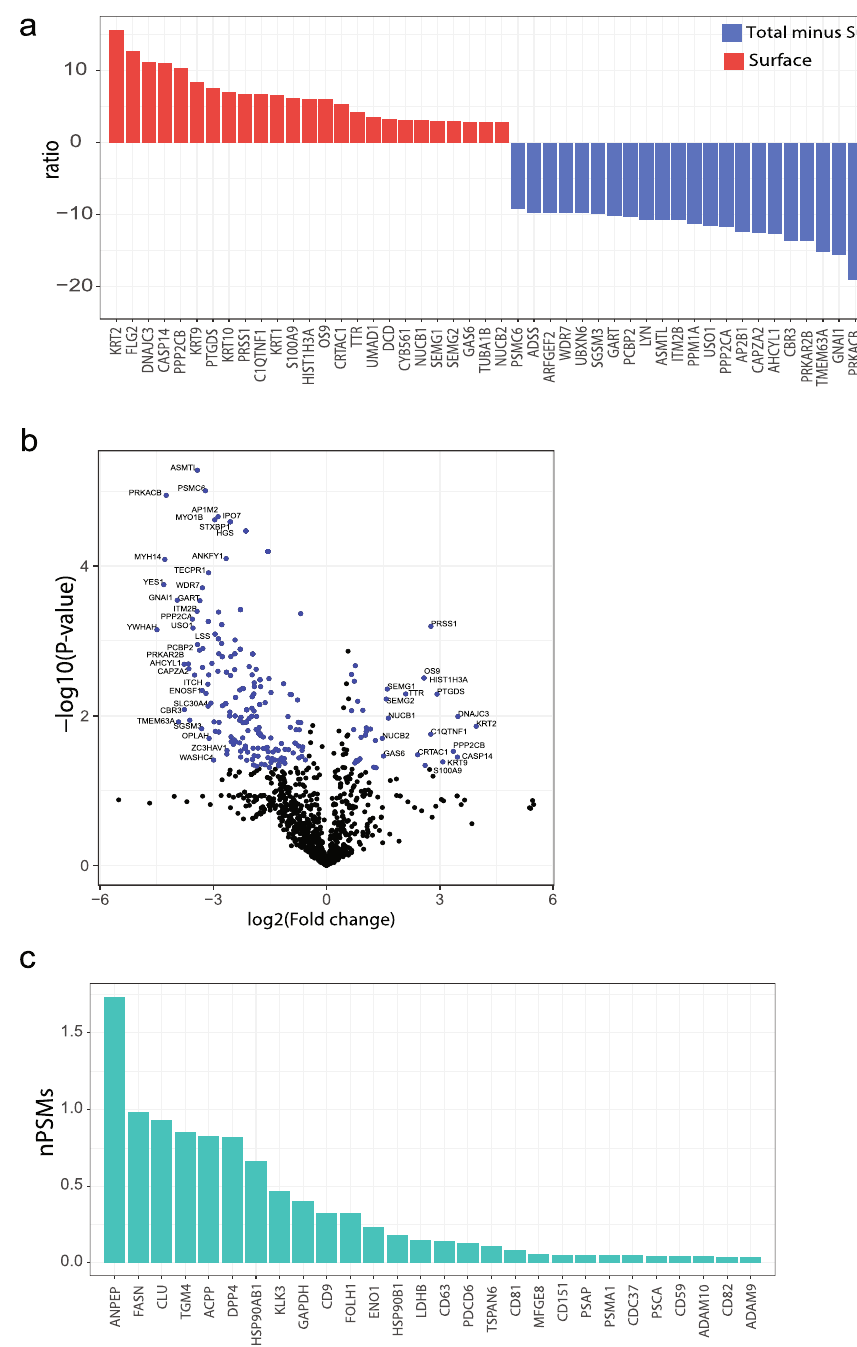
Fig. 4 Surface proteins expression in SF-EVs. a Proteins identi fi ed in the surface and in total minus surface fractions were compared by fold change and t-test statistical analysis. a The bar plot represents the ratio of the 25 most enriched proteins in surface and in total minus surface fractions. b The volcano plot represents fold changes and P -value for proteins identi fi ed at least in two samples. c Abundance in normalized peptide spectrum matches (nPSMs) of known sEV markers in the surface fraction of